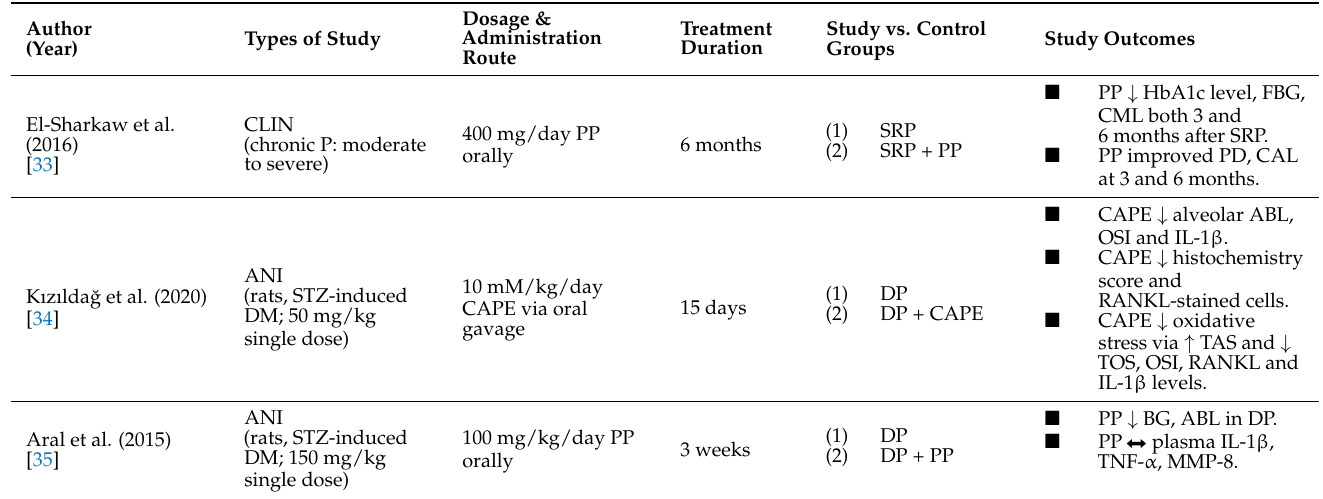
Table 5. Studies on the use of propolis (PP) in diabetes-associated periodontitis